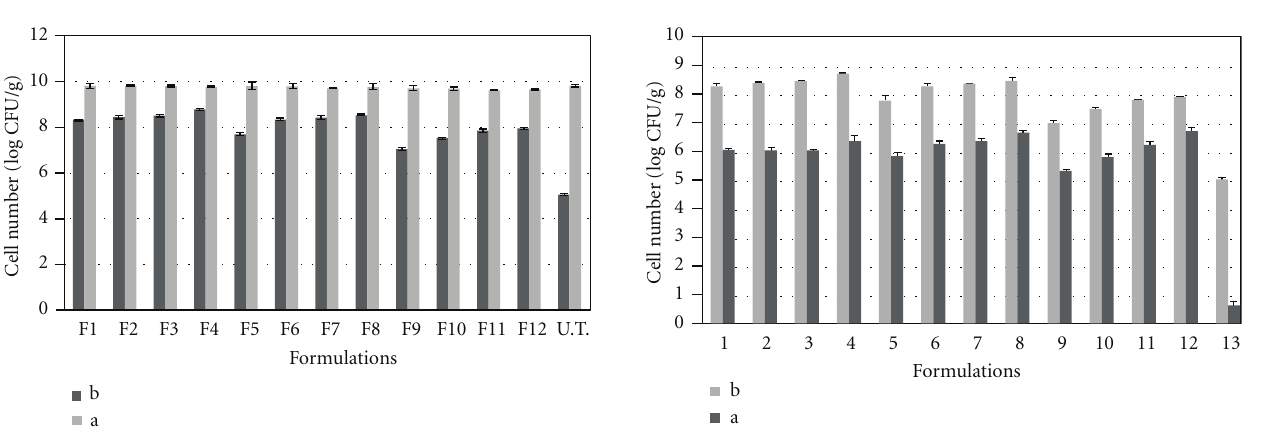
Figure 2: The viability of L. acidophilus (CFU/g) encapsulated in di ff erent ALG or ALG-PSL beads (F1–F12) and untreated cells. (a) Counts of the bacteria after 2h acid exposure, (b) Initial counts of prepared beads and untreated cell count.